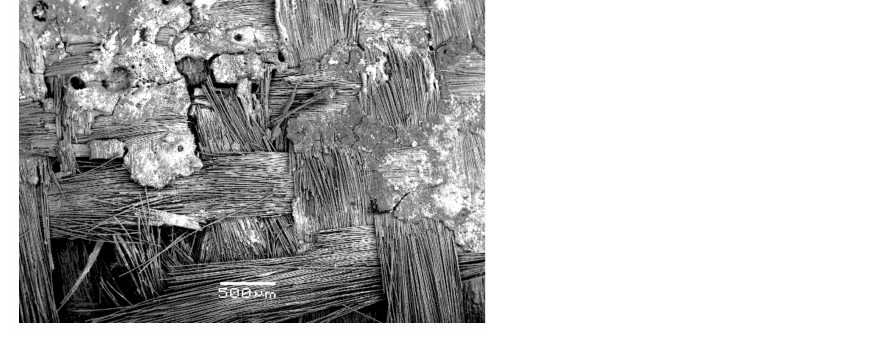
Figure 21. SEM image of the surface of the textolite material with a copper compounds sediment and very strong degradation effects (magnified 35 times). The resin on the top layer of the material was almost completely charred and burned out. Damage to the textile support is visible. There were cracks and characteristic cavities in the sediment layer.